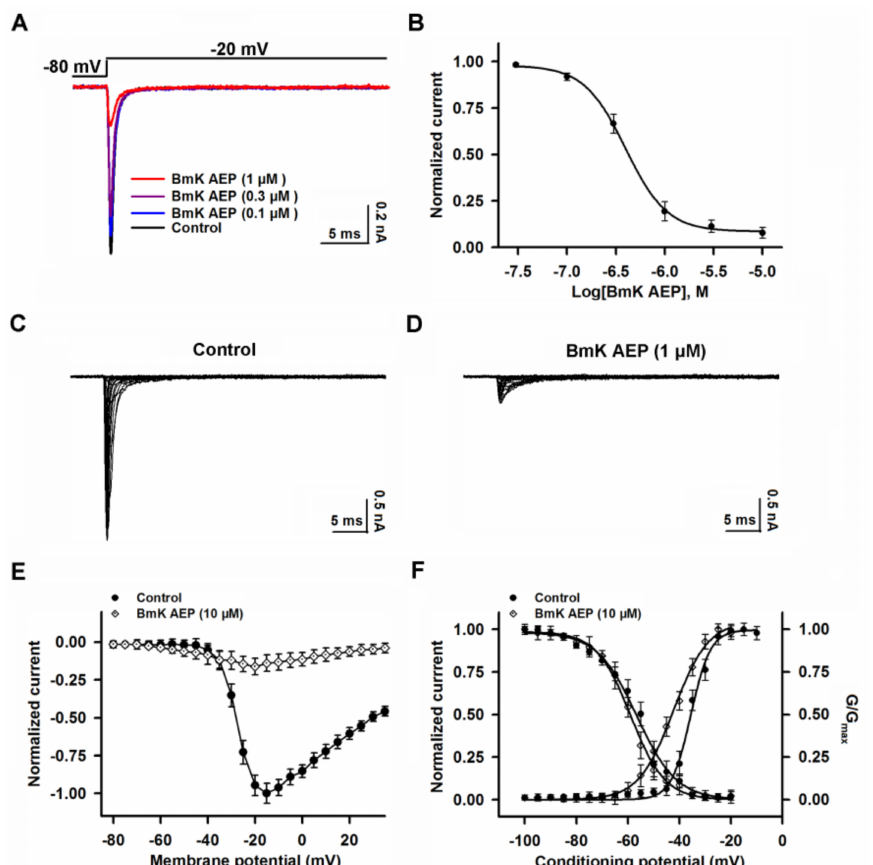
Figure 6. Influence of BmK AEP on hNa v 1.6 expressed in HEK-293 cells. ( A ) BmK AEP suppressed the Na v 1.6 peak current. Na + currents were elicited by a 50-ms depolarization to − 20 mV from a holding potential of − 80 mV. ( B ) Concentration–response relationship curve of BmK AEP inhibition of Na v 1.6 currents. ( C , D ) Representative traces of Na v 1.6 currents in the absence and presence of 10 µ M BmK AEP, respectively. Currents were trigged by 50-ms depolarizations from − 80 to 30 mV in a 5-mV step. ( E ) Normalized I–V relationships of Na v 1.6 currents in the absence and presence of 10 µ M BmK AEP. ( F ) Effect of BmK AEP (10 µ M) on the steady-state activation and inactivation of Na v 1.6. Each data point represents the mean ± SEM ( n = 5–7). Table 1. The potency and maximum inhibition of BmK AEP in brain subtypes of VGSCs. VGSC